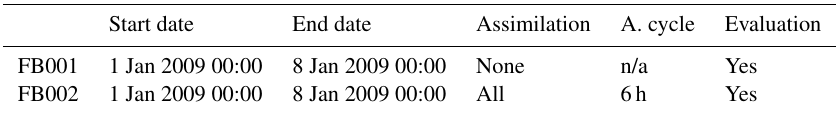
Figure 4. Salinity (a, c) and temperature (b, d) variance of the initial ensemble at 5m (a, b) and 20m (c, d) depth on 1 January 2009 at 00:00UTC. Table 2. Summary of the OSSEs. Start and end date of both experiments are the same. There is no assimilation in FB001 whereas all the data are assimilated in FB002. Assimilation cycle is 6h for